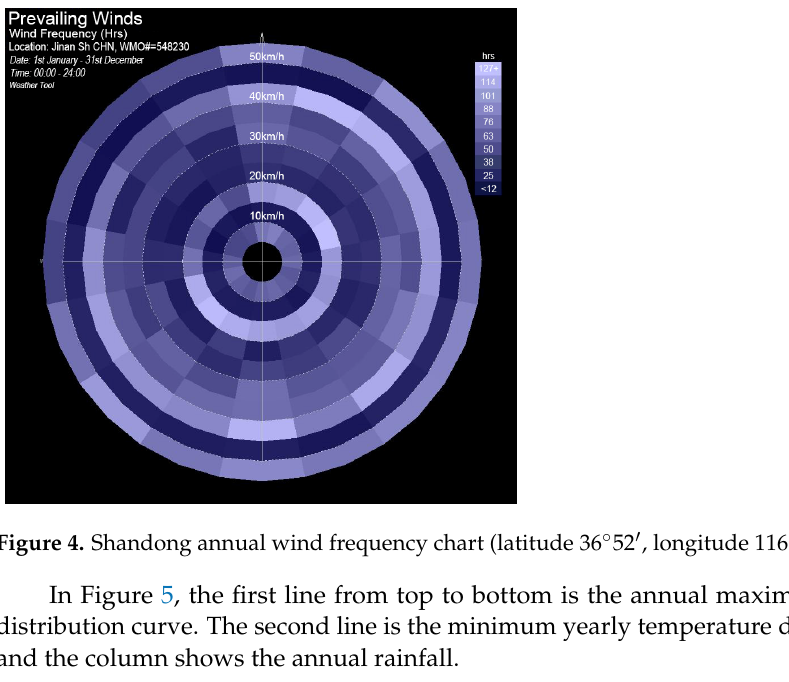
Figure 3. Liaocheng City map.